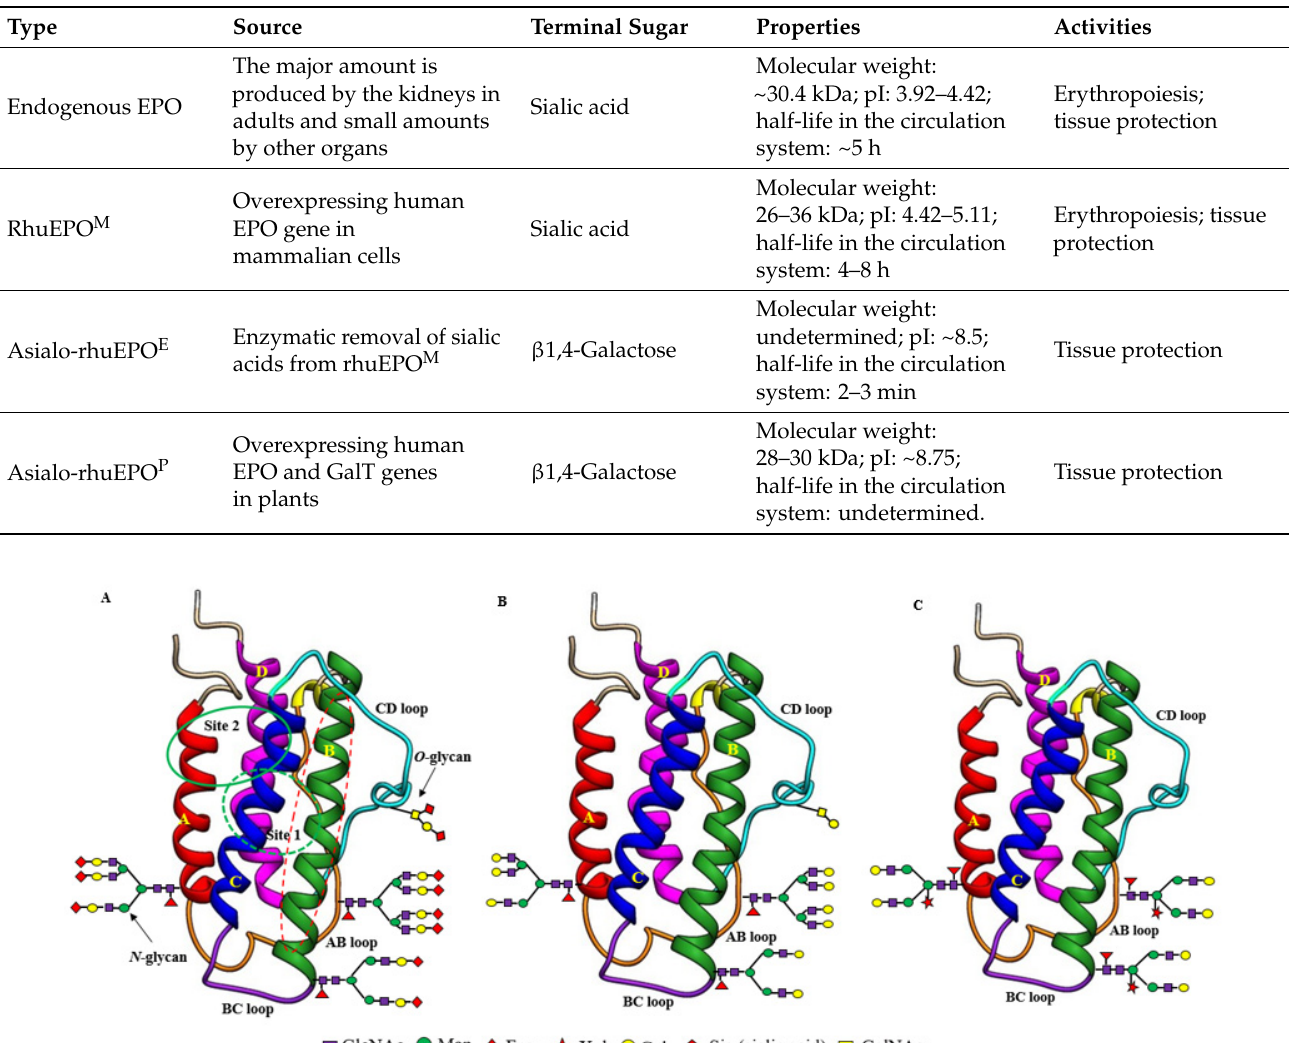
on asialo-rhuEPO to warrant its success in future clinical